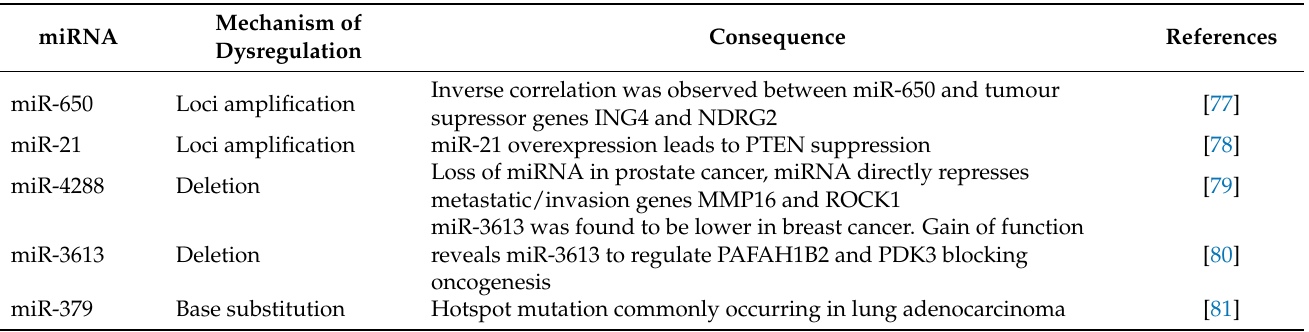
Table 1. Table showing various mechanisms of dysregulation of miRNA in